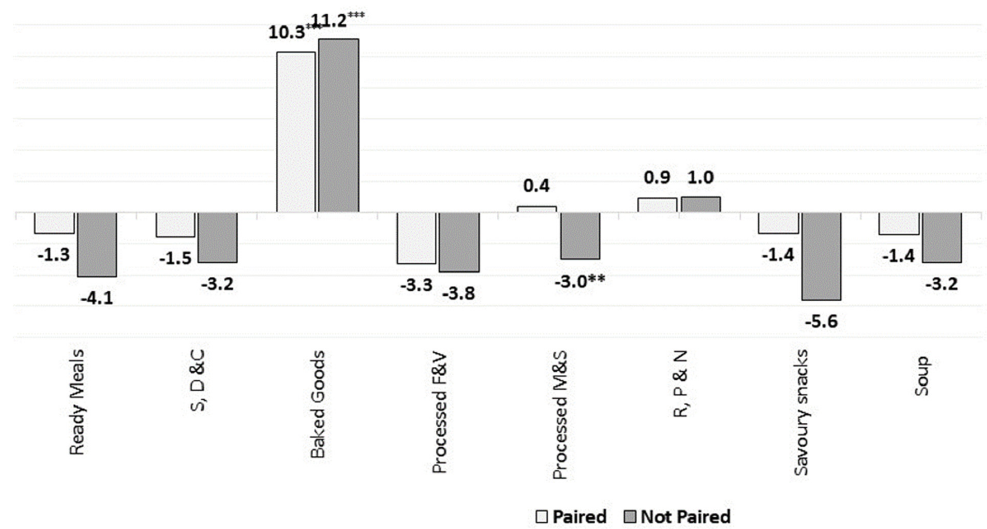
Figure 13. Percentage changes in the market-weighted mean salt content in paired and unpaired packaged food and soft drinks products in Europe (2015–2018). Source: Elaborated by the authors based on data from Euromonitor (2020). Note: Percentage of products with available information both in 2015 and 2018: 88% for S, D & C, Savoury Snacks, Soup and Ready Meals, 91% for Baked Goods and Processed Meats, and 84% for R, P & N. Significance levels: ** 5%, *** 1%.